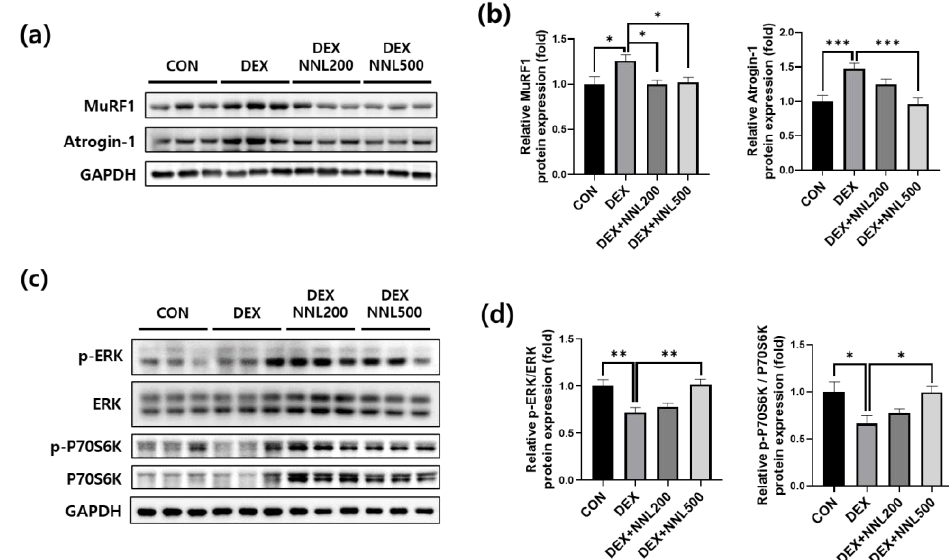
Figure 4. The NNL extract decreased the expression of muscle degradation factors and increased the expression of muscle synthesis factors in DEX-induced muscle atrophy in mice. ( a,b ) The protein levels of MuRF1 and atrogin-1 in the QD muscle were analyzed by immunoblotting, quantified using ImageJ software, and normalized to those of GAPDH. ( c,d ) The protein levels of phosphorylated ERK and P70S6K in the QD muscle were analyzed by immunoblotting, quantified using ImageJ software, and normalized to ERK and P70S6K, respectively. Representative images ( a,c ) and quantitative analysis bar graphs ( b,d ) are shown. Data are shown as mean ± S.E.M., n = 6/group; * p < 0.05, ** p < 0.01, *** p < 0.001.